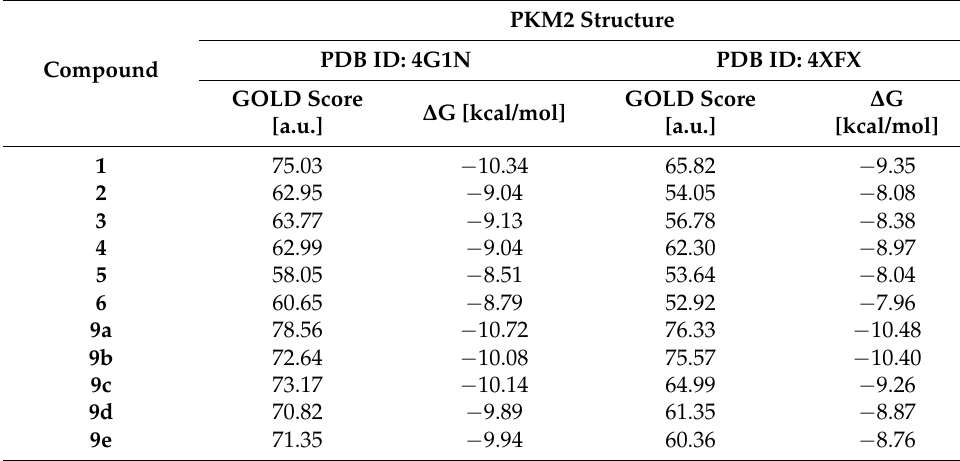
Figure 2. Molecular structures of novel 8-quinolinesulfonamide derivatives ( 9a – e ) as potential PKM2 modulators. Table 1. Molecular docking results obtained with GOLD for PKM2 modulators ( 1 – 6 ) and newly designed 8-quinolinesulfonamide derivatives ( 9a – e